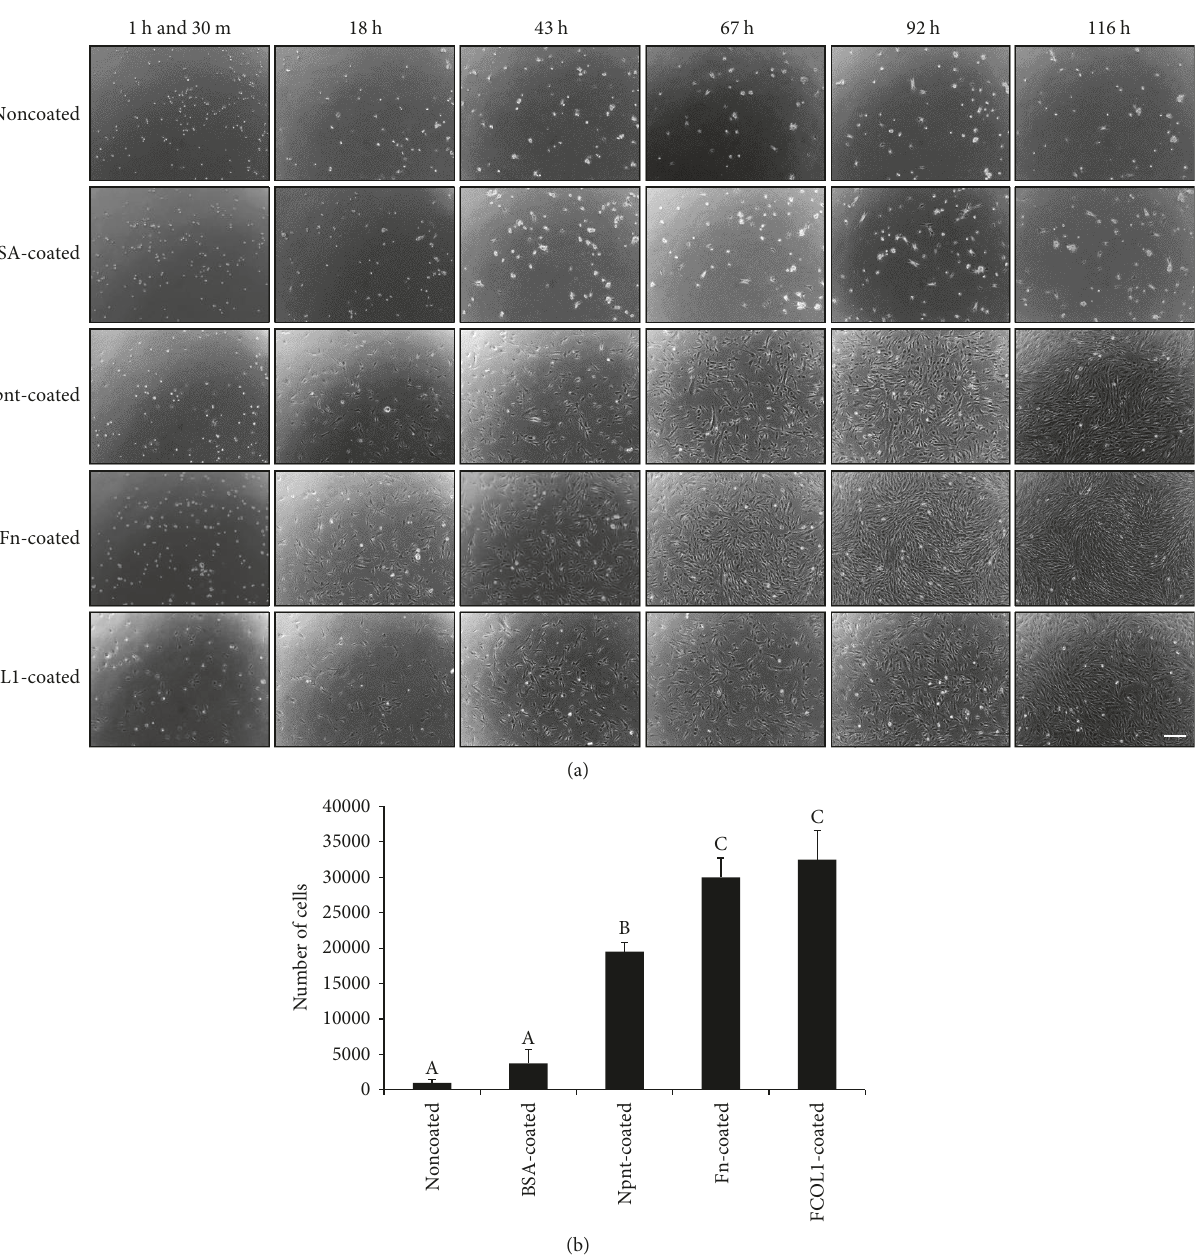
Figure 2: Microscopic observation and cell number counting. (a) hDPSCs were seeded into PBS-, BSA-, Npnt-, Fn-, or FCOL1-coated 24-well plates (non-PS) at the concentration of 4 × 10 3 /well in DMEM supplemented with 10% FBS, penicillin/streptomycin (50 U/mL; 50 μ g/mL) (scale bar: 200 μ m). Cell morphology was observed at 1 h and 30m, 18h, 43h, 67 h, 92 h, and 116 h. (b) hDPSCs were seeded into 24-well plates (non-PS) at the concentration of 4 × 10 3 /well in the same culture media as illustrated in (a), cell number was counted at day fi ve. Di ff erent symbols represent signi fi cant di ff erences, p < 0 01 by post hoc Tukey ’ s HSD